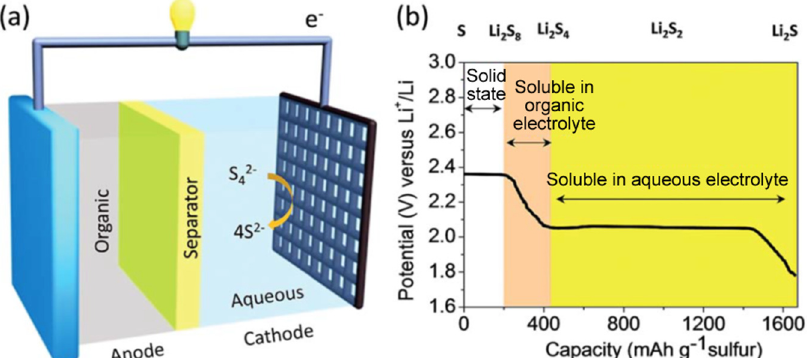
Figure 2. ( a ) Illustration of a Li-S battery and the ( b ) electrochemical species formed during lithiation. Reproduced with permission from [14]. The Royal Society of Chemistry, 2015.